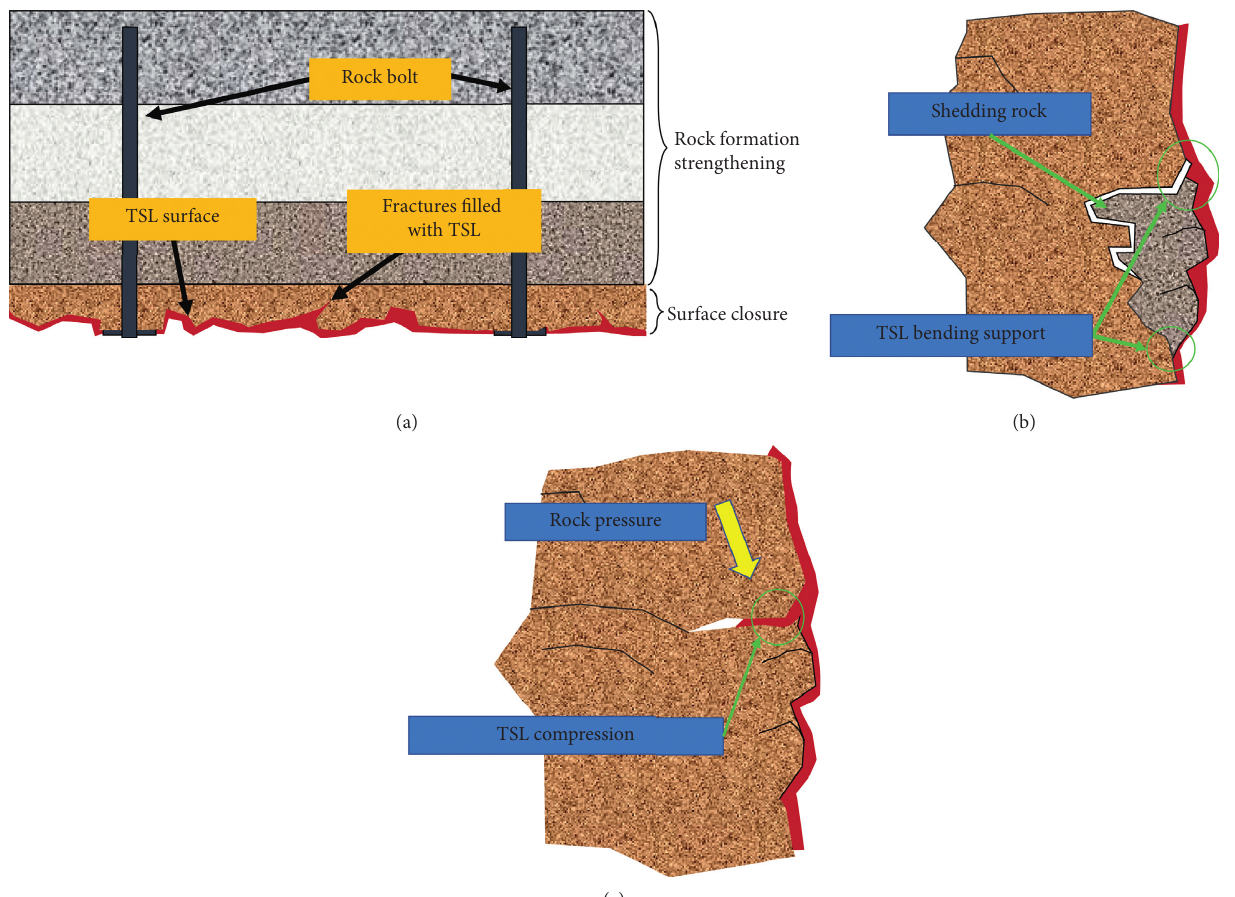
Figure 1: (a) Schematic diagram of TSL use in the roadway. (b) TSL basket action. (c) TSL wedge